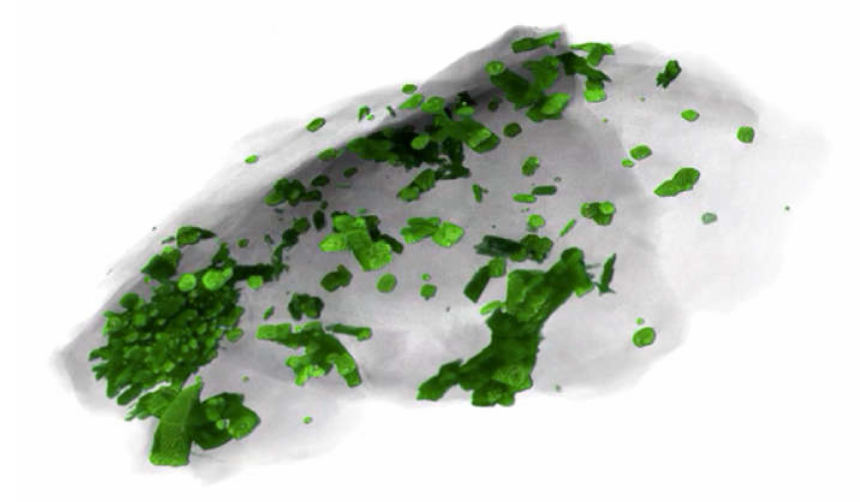
Figure 4. A 3-D perspective by X-ray tomography of a magma chip (2 mm long), from IDDP-1. False-color green crystals, mostly plagioclase, float in transparent gray melt. A clot of crystals at the lower left is partially melted felsite. The chip was quenched at about 2100 m depth and 900 ◦ C. Credit: Sample provided by Landsvirkjun and A. Mortensen; image by F. Wadsworth, Munich U., Germany; E. Saubin, U. of Canterbury and C. I. Schipper, Victoria U.,